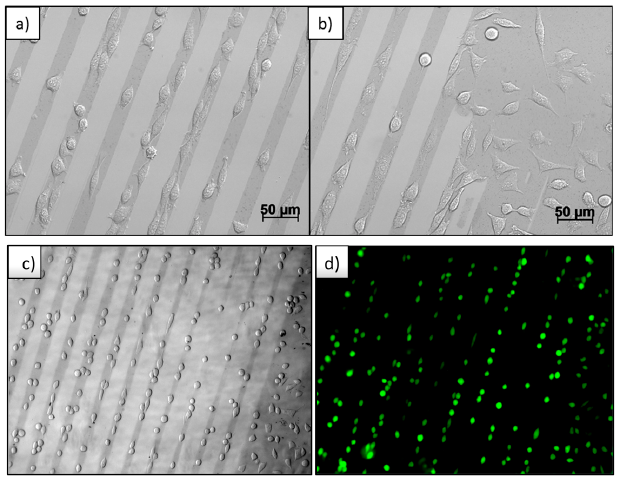
Figure 7. ( a – c ) Optical images of fibroblast adhesion on Au NPs patterned PEG-hydrogel. The darker lines correspond to the patterns of Au NPs; ( d ) live-dead assay.